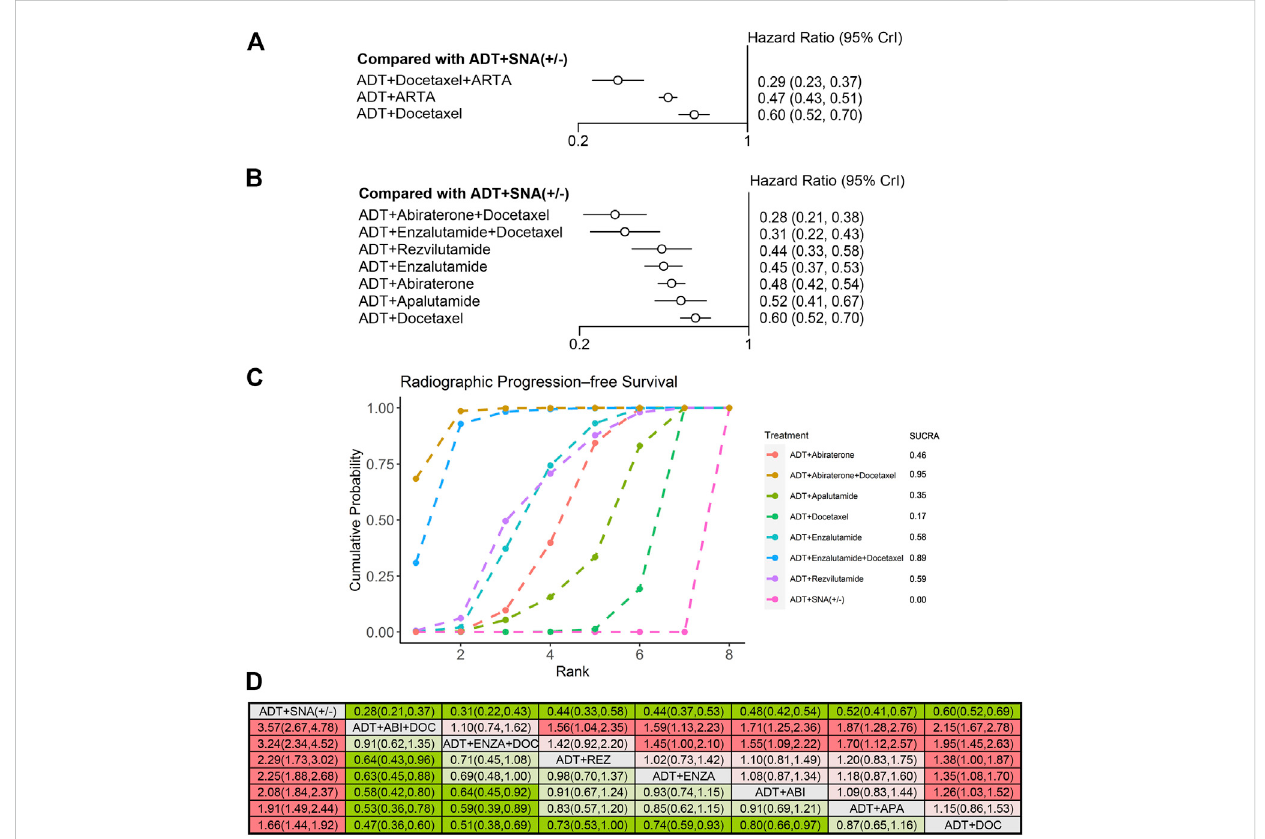
FIGURE 5 Comparison of therapies for improving rPFS in patients with high-volume disease. (A) Forest plot representing HR for combination therapy compared with ADT with or without SNA. (B) Forest plot representing HR for speci fi c therapy compared with ADT with or without SNA. (C) SUCRA plot showing the treatment ranking of speci fi c therapies. (D) League table of NMA comparing the rPFS. Comparison is located at the intersection of the column-de fi ning treatment and the row-de fi ning treatment. The results are presented in HR with 95% CrI. HR > 1 (red) favors row-de fi ning treatment, and HR < 1 (green) favors column-de fi ning treatment. The dark red or green represents the results with statistical signi fi cance. DOC, Docetaxel; ABI, Abiraterone, ENZA, Enzalutamide; APA, Apalutamide; REZ, Rezvilutamide; rPFS, radiographic progression-free survival; ADT, androgen deprivation therapy; SNA, standard non-steroidal antiandrogen; HR, hazard ratio; NMA, network meta-analysis; SUCRA, surface under the cumulative ranking